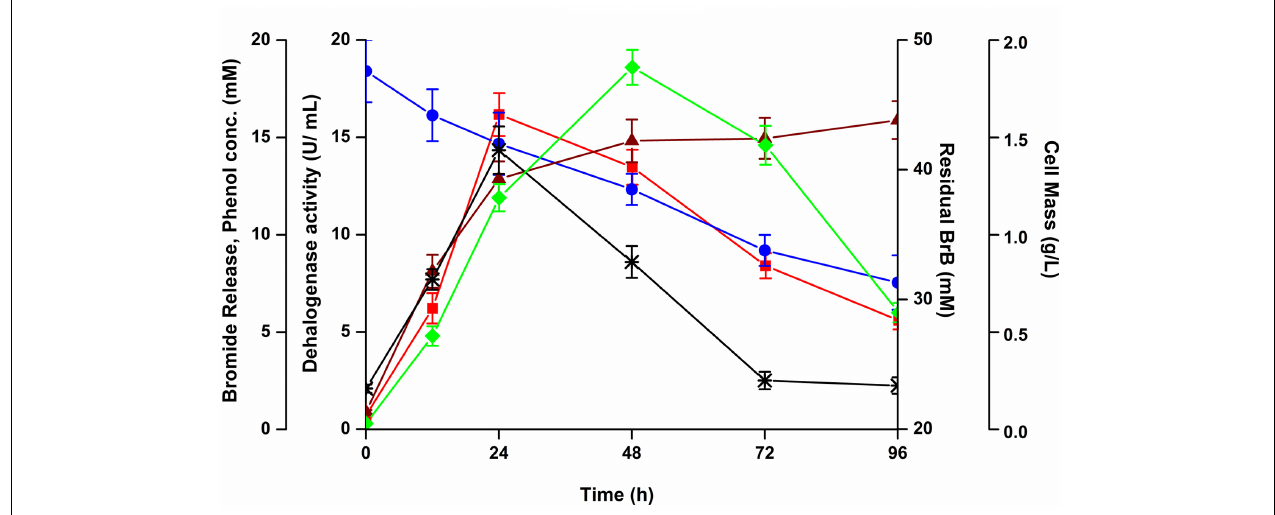
FIGURE 3 | Effect of bromobenzene on the growth, bromide release, degradation and dehalogenase activity of Y. lipolytica. The yeast was grown on 0.5% (v/v; 47.6 mM) of bromobenzene in sealed flasks and growth monitored by measuring cell mass ( (cid:7) ), bromide release ( (cid:78) ), dehalogenase activity ( (cid:4) ), residual bromobenzene ( ), and phenol concentration ( ∗ (cid:32)